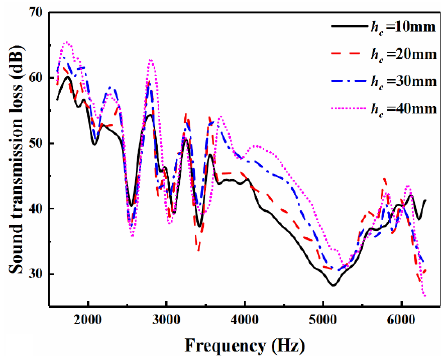
Figure 14. Test results for four structures with honeycomb cores of different thickness.